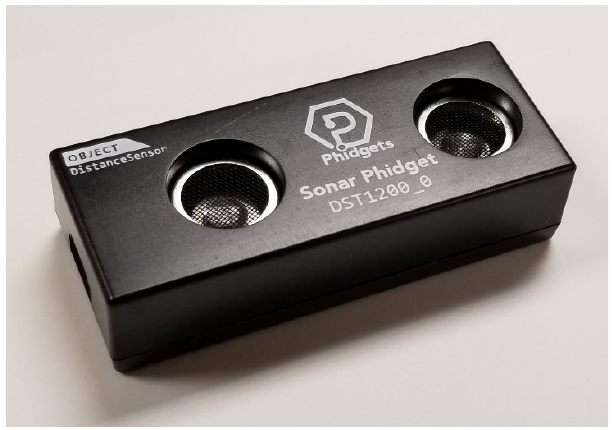
Figure 6. Sonar Phidget DST1200_0 ultrasonic sensor. Table 2. Sonar Phidget DST1200_0 sensor specifications (based on information from [44]).